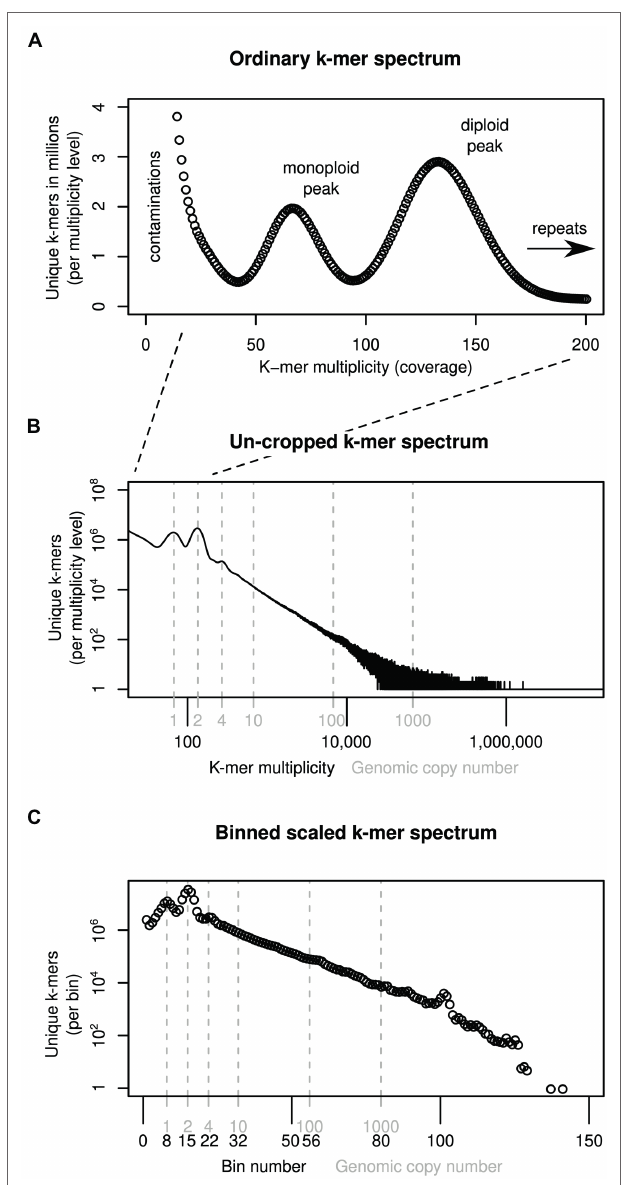
FIGURE 1 | Ways of depicting individual-sample k-mer data sets. Panel (A) shows a k-mer spectrum with linear axes and the multiplicity ( x -axis) cropped at 200, excluding k-mers present in genomic repeats. To represent all sample k-mers, the axes may be scaled logarithmically as in (B) . To compare samples, the multiplicity values can be scaled and binned (C) . See main text for more